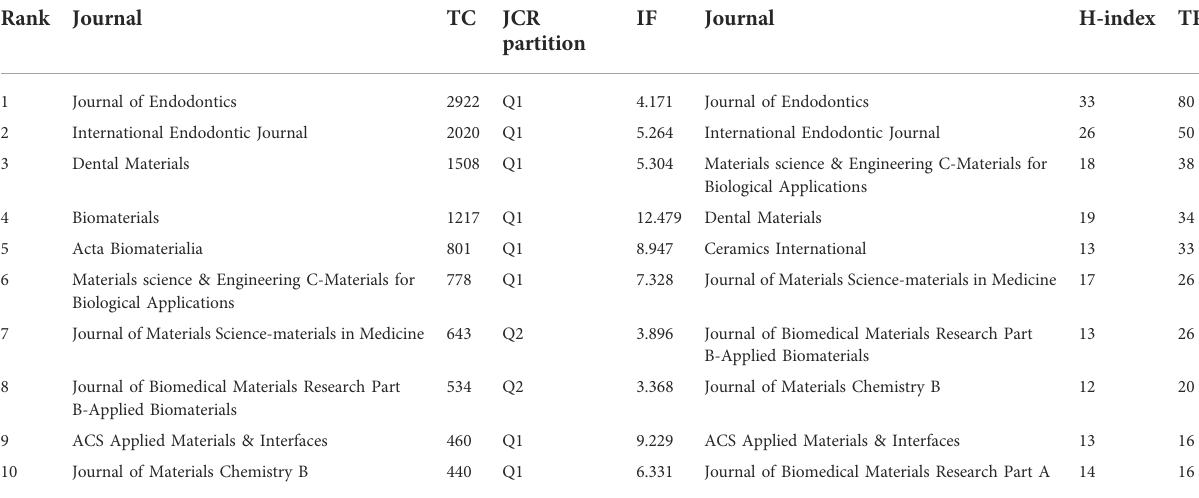
TABLE 1 Top 10 journal by cited and